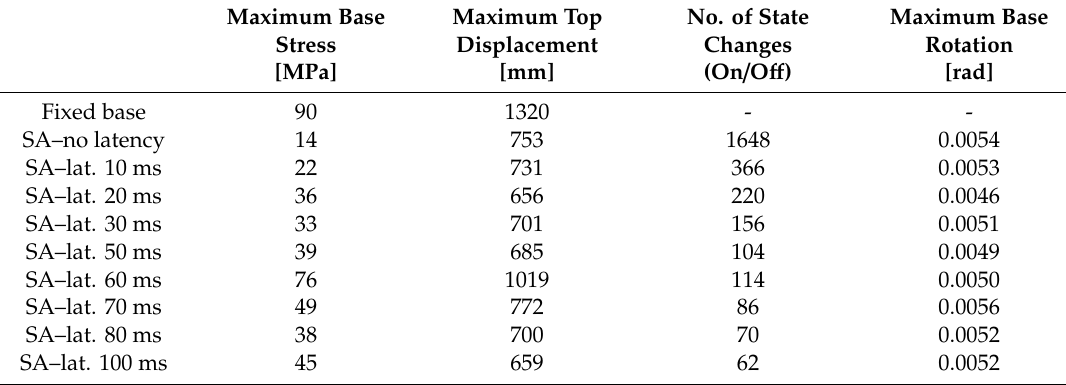
Table 5. Peak response of the wind turbine by varying the latencies of measurements.